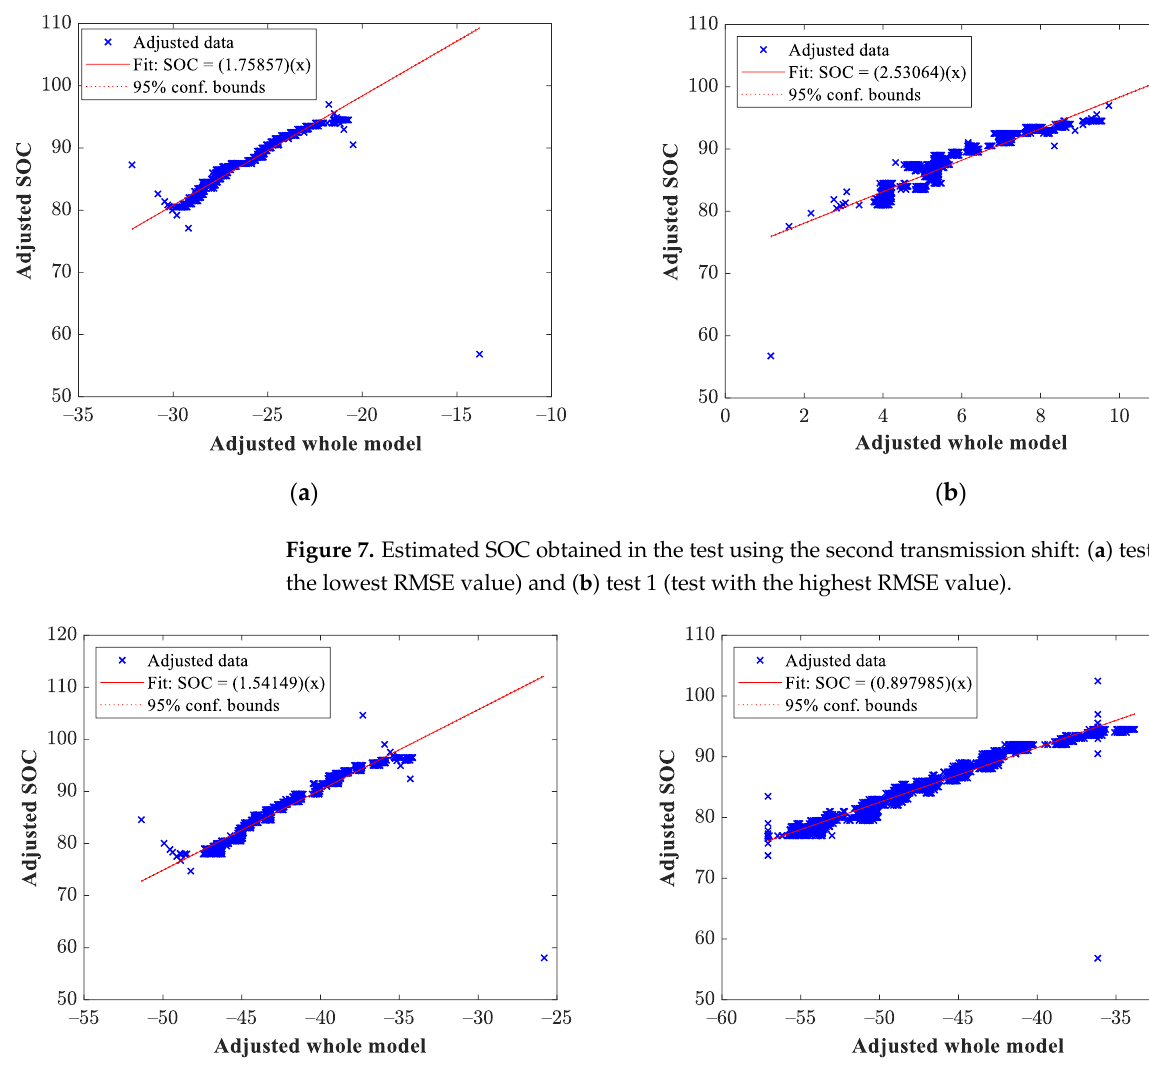
Figure 6. Evolution of the RMSE value through the generations for the third transmission shift tests: